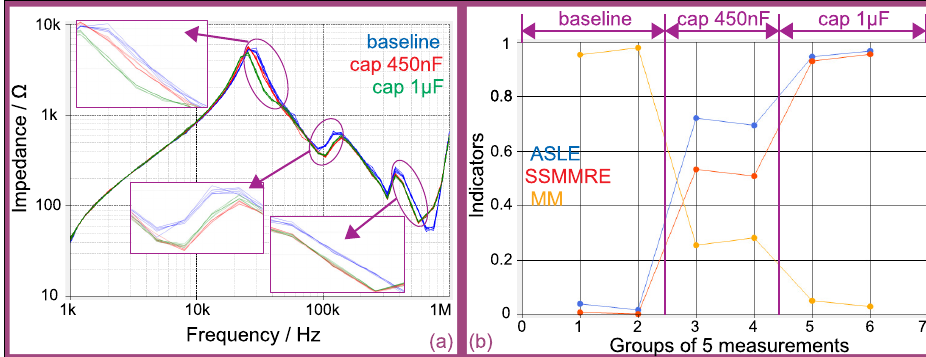
Figure 15. Offline FRA for a progression of turn insulation failure (capacitors inserted between taps): ( a ) impedance spectra; ( b ) trend curves of some statistical